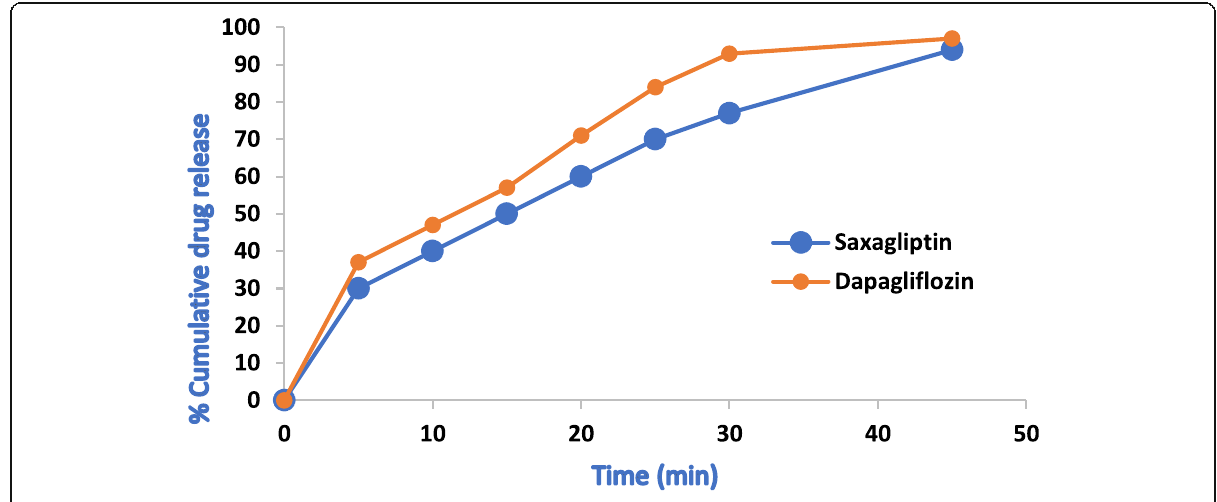
Fig. 4 Dissolution profile of drugs in marketed dosage form (QTERN)